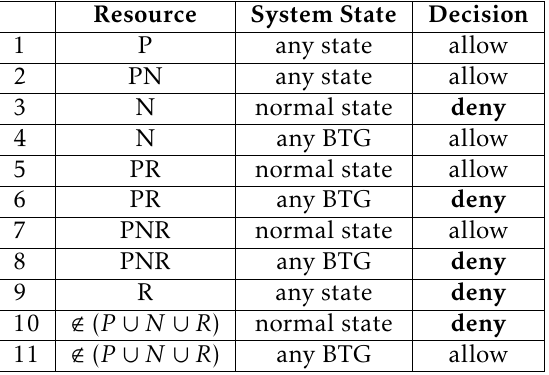
Figure 4. Sample access control table for a physician